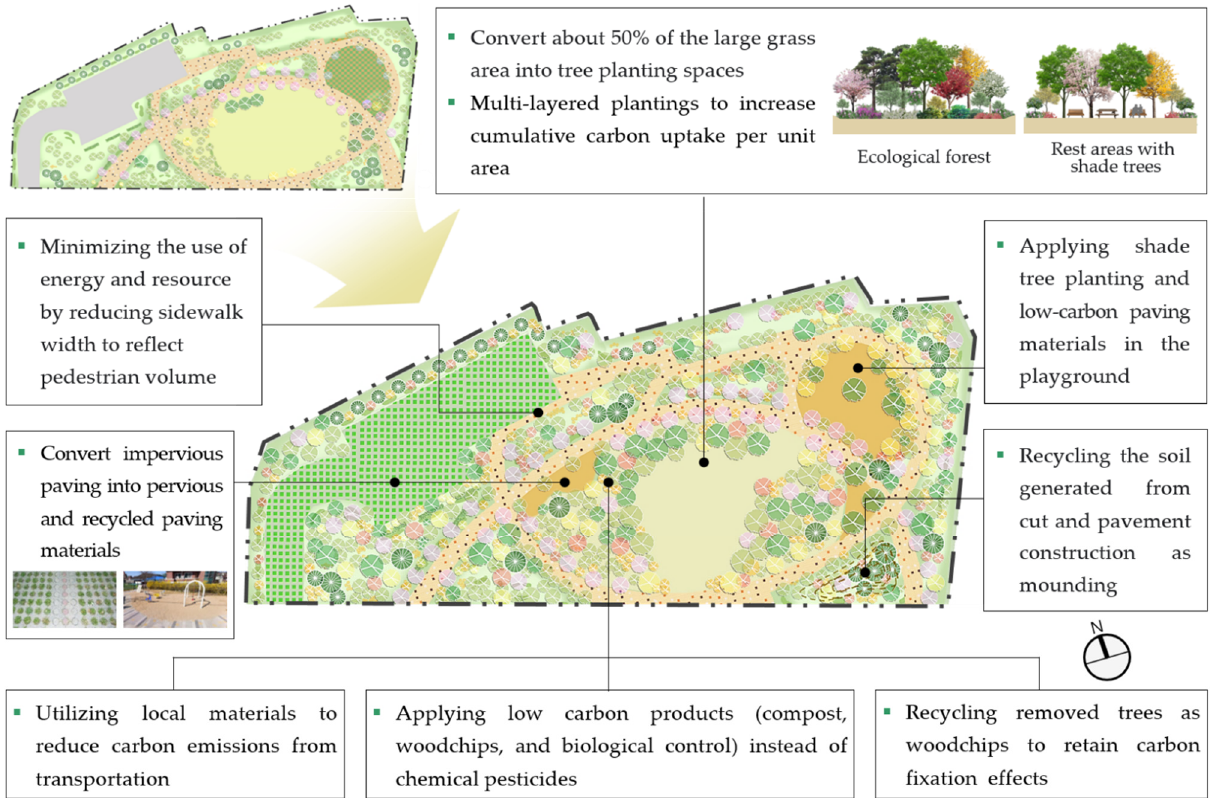
Figure 7. Ecological design and construction strategies to enhance carbon reduction effects of study parks.